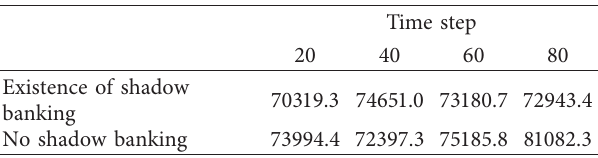
Figure 4: (a) The impact of the existence of shadow banking on the cumulative number of default banks in the banking system. (b) The impact of the existence of shadow banking on changes in bank survival ratio in the banking system. (c) The impact of the existence of shadow banking on the ratio of bank default rate to commercial bank survival rate. (d) The impact of the existence of shadow banking on the changes in the amount of central bank assistance (the parameter settings are the same as in Figure 3). Table 1: The liquidity of the system under the existence of shadow banking and no shadow banking at evolutionary